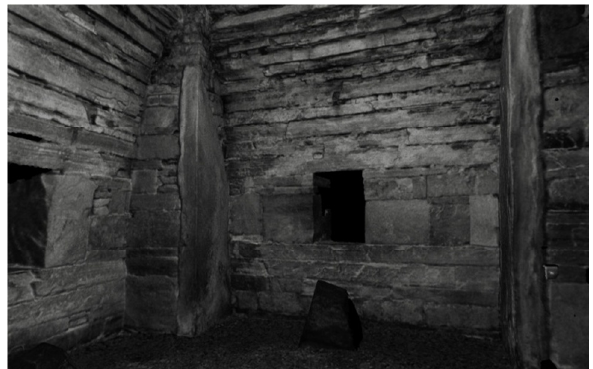
Figure 14. Meshed point cloud data showing interior of Maeshowe chambered tomb. The mesh was generated from a single scan with an interpolation step of 6mm and contains 12 million polygons. It shows intensity values from the scanner in greyscale © CDDV